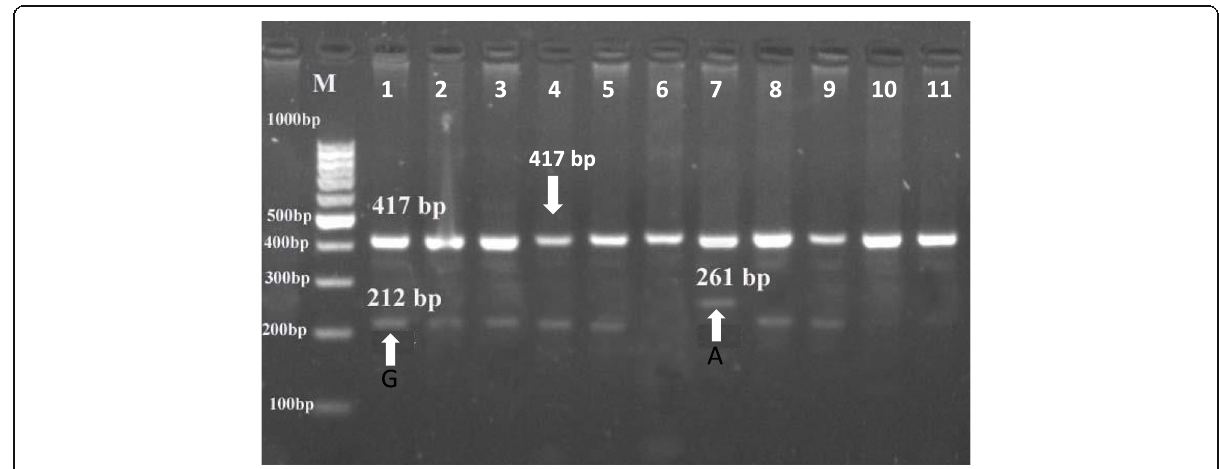
Fig. 2 Electrophoresis of agarose gel (2%) of polymerase chain reaction (PCR) product of tetra-primer amplification refractory mutation system- PCR for G4 locus of GDF9 gene. The Lanes of 1 to 11: Amplification of wild type or heterozygous in a mother sheep genomic DNA. Sizes of the common outer product (417bp) and allele-specific wild type (261bp) and mutant-type (212bp) inner product are indicated by an arrow of the respective